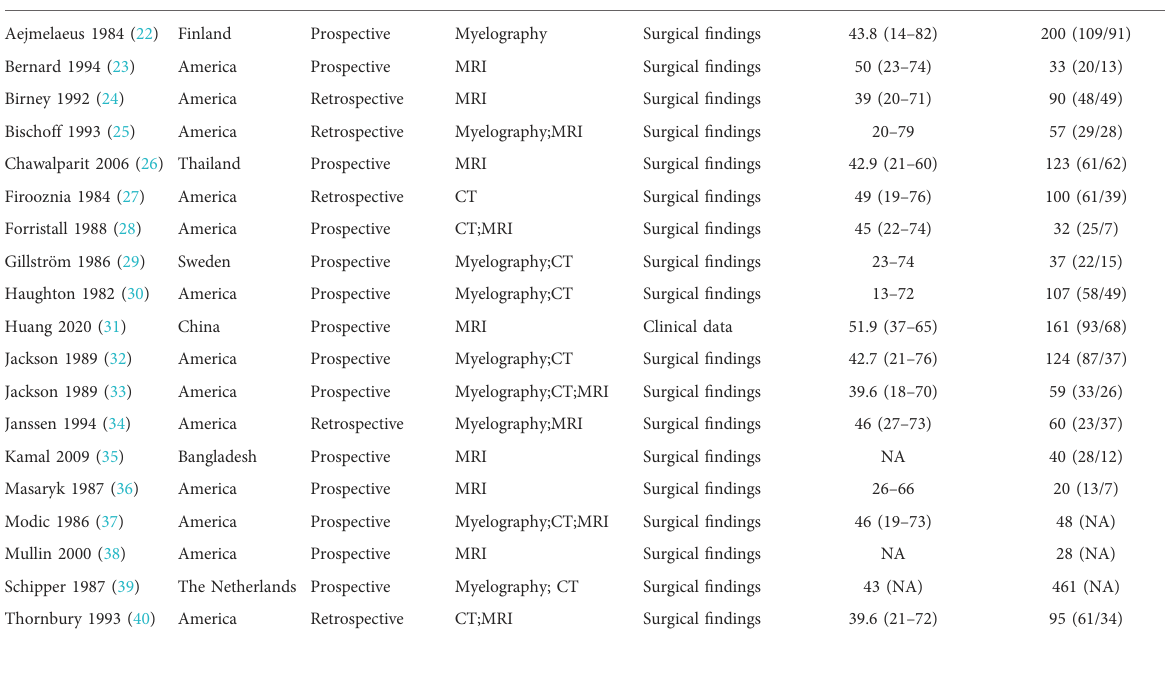
TABLE 1 Characteristics of included studies.